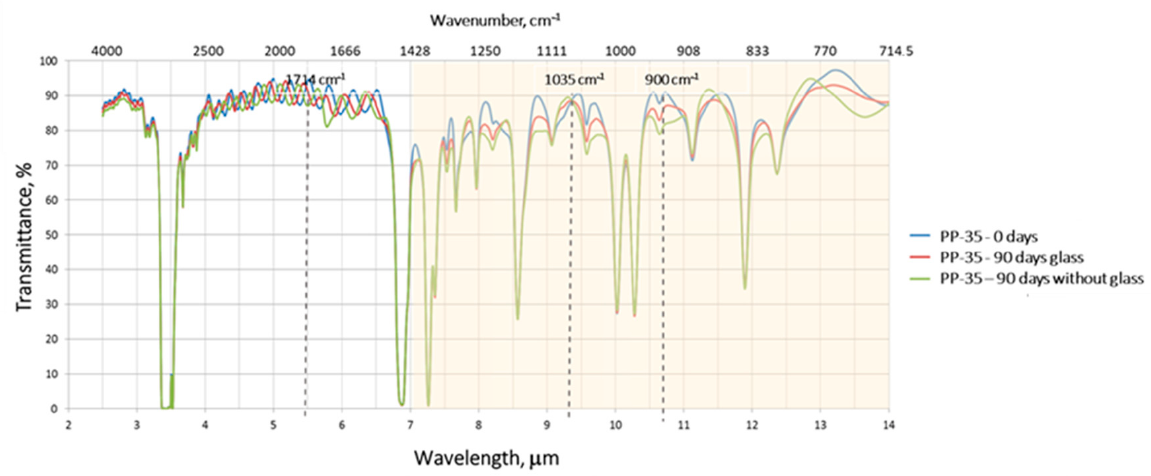
Figure 11. PP-35 FT-IR spectra in transmission mode.